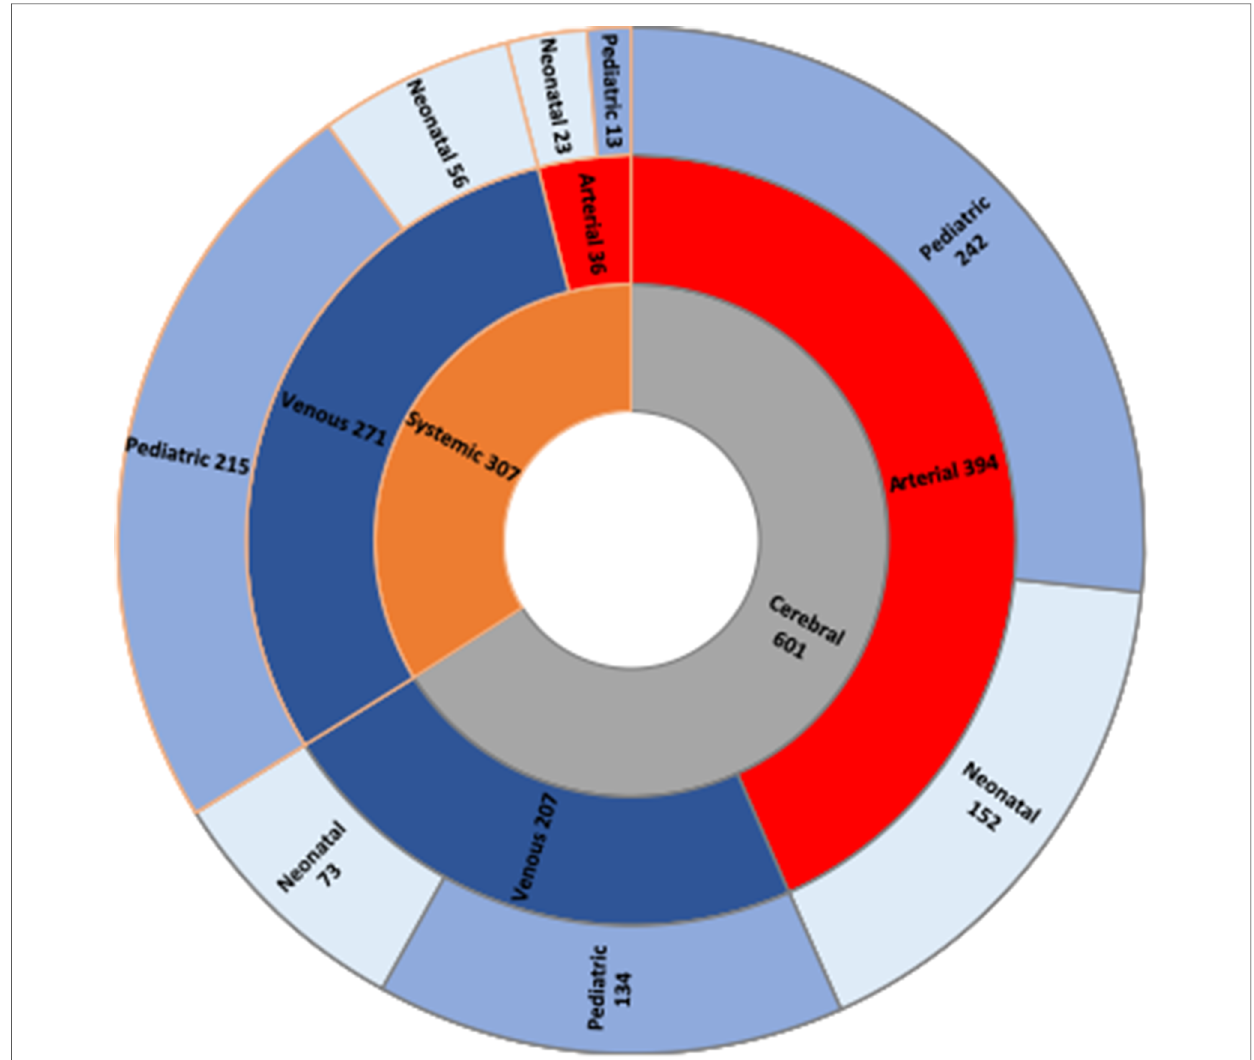
FIGURE 3 Thrombotic events strati fi ed in three layers. The innermost layer shows the strati fi cation between cerebral thrombotic (gray) and systemic (orange) events can be seen. The middle layer shows the distribution of arterial (red) and venous (blue) events. Finally, in the outermost layer the age strati fi cation is displayed: neonatal events (light blue) and paediatric events